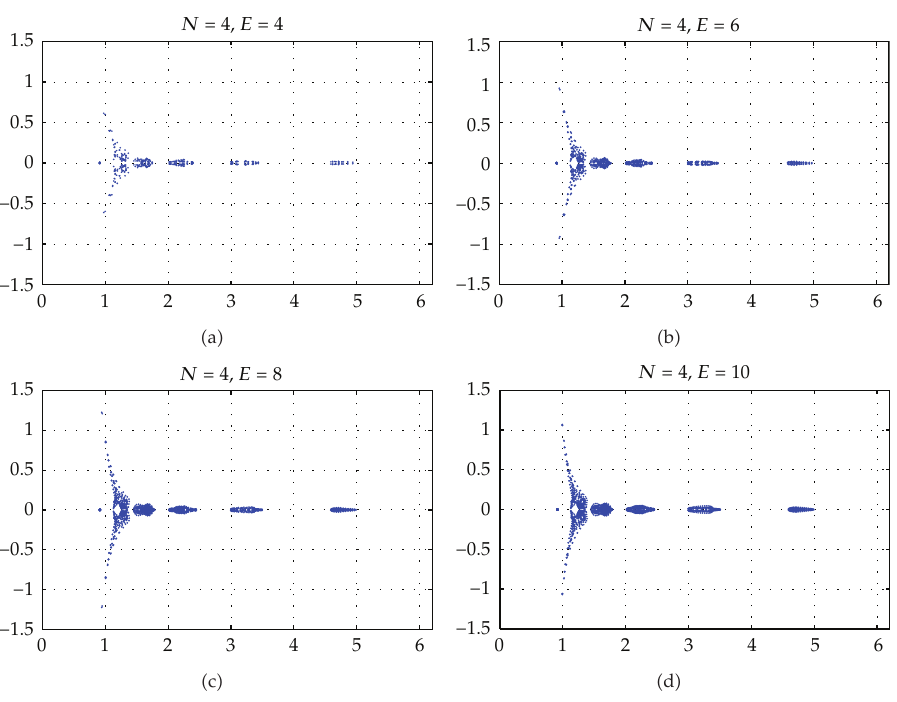
(cid:2) B − 1 (cid:2) A E (cid:2) 4 , 6 , 8 , 10 and N (cid:2) 4 when δ (cid:2) 1 , b (cid:2) (cid:5) 1 , 1 (cid:6) T . N 2 for h 2